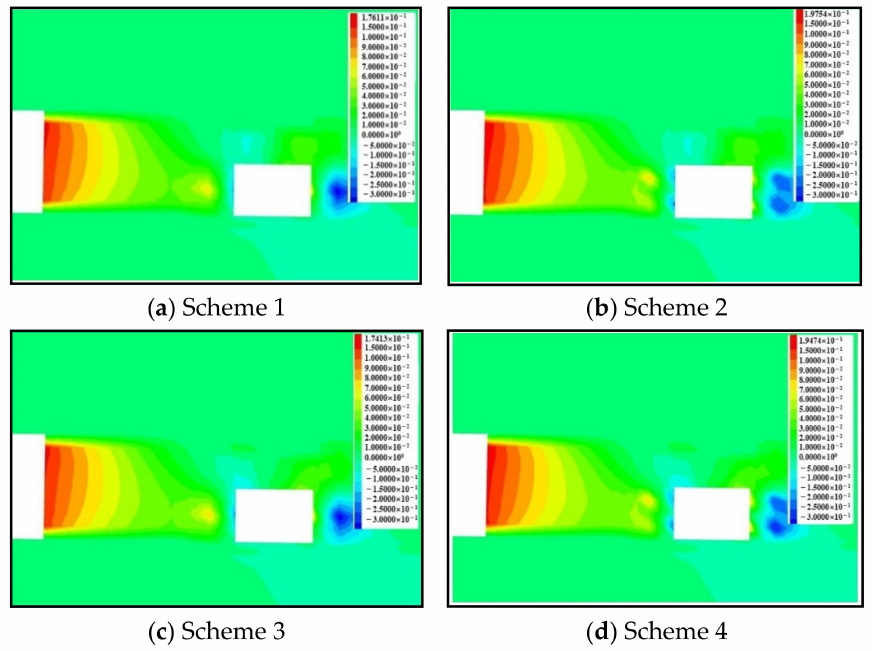
Figure 13. Cloud map of horizontal deformation of the gob-side roadway: ( a ) Scheme 1; ( b ) Scheme 2; ( c ) Scheme 3; ( d ) Scheme